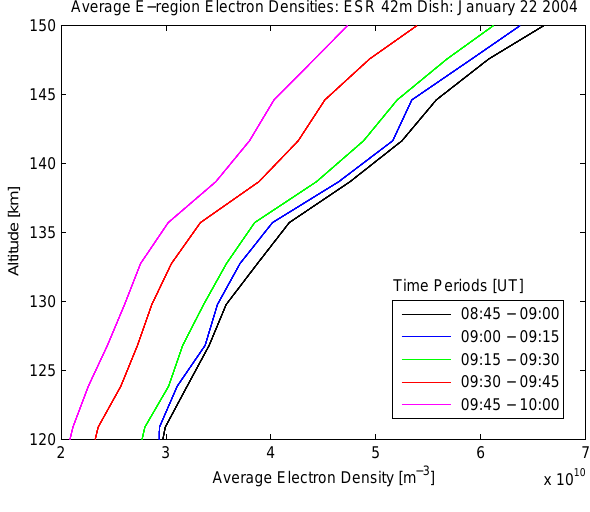
Fig. 9. Average ESR raw electron densities (Debye-corrected) for consecutive 15min intervals between 08:45UT and